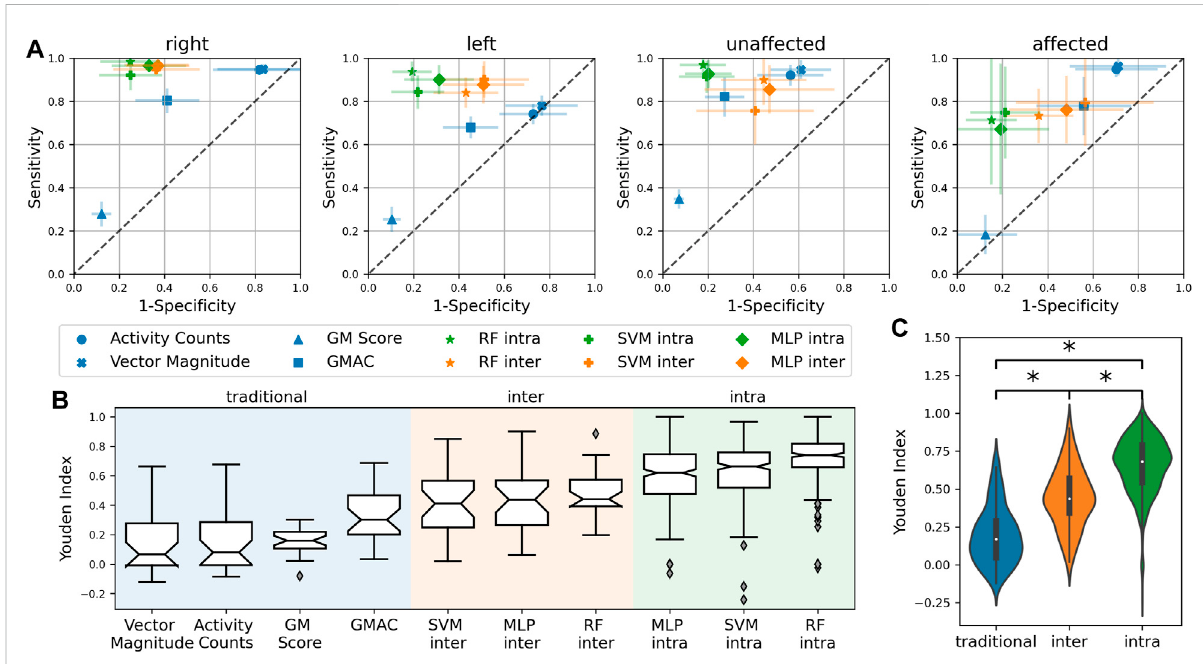
FIGURE 4 (A) Sensitivity vs. ‘ 1-Speci fi city ’ plots depicting the performance of the different measures. The closer a measure is to the top-left corner, the betteritsperformance.Thediagonaldashedgraylinedepictstheperformanceofarandomclassi fi er. (B)